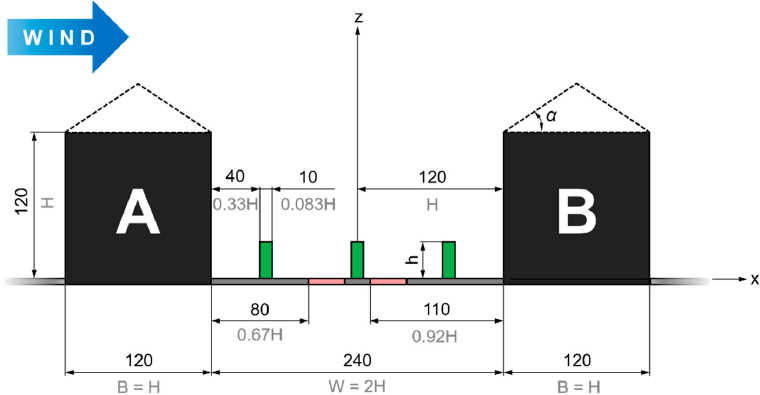
Figure 2. Side view of the street canyon. Low boundary walls are indicated with green and pollution sources are marked with pink. sources are marked with